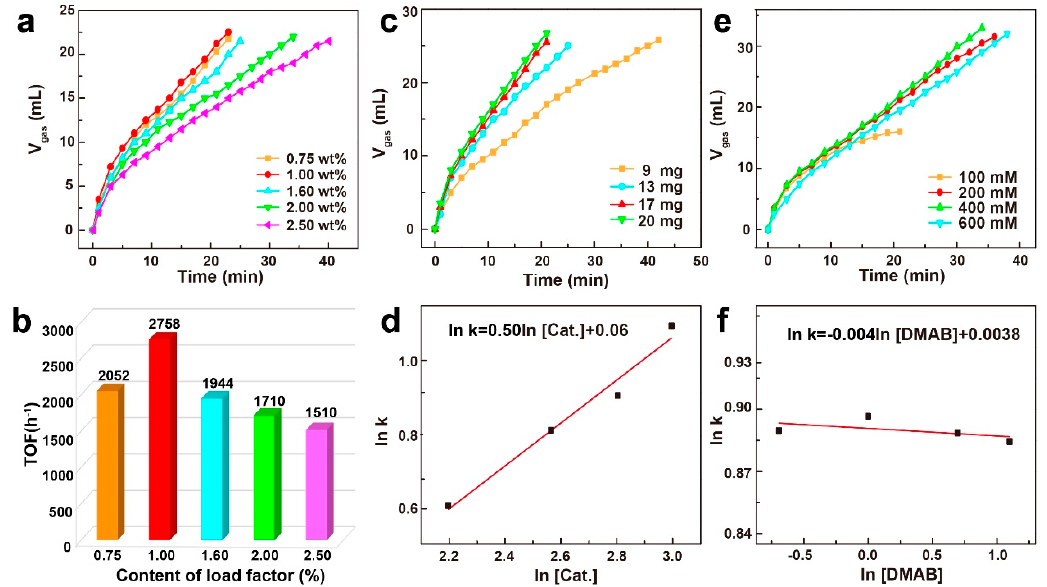
Figure 3. ( a ) Hydrogen production vs time over Pd/NPC with varied Pd loadings. (b) The corresponding TOF values. ( c ) Hydrogen generation vs time over Pd/NPC with varied catalysts mass. ( d ) Plot of ln rate vs ln [Cat.]. ( e ) Hydrogen evolution vs time over Pd/NPC with varied DMAB concentrations. ( f ) Plot of ln rate vs ln [DMAB].